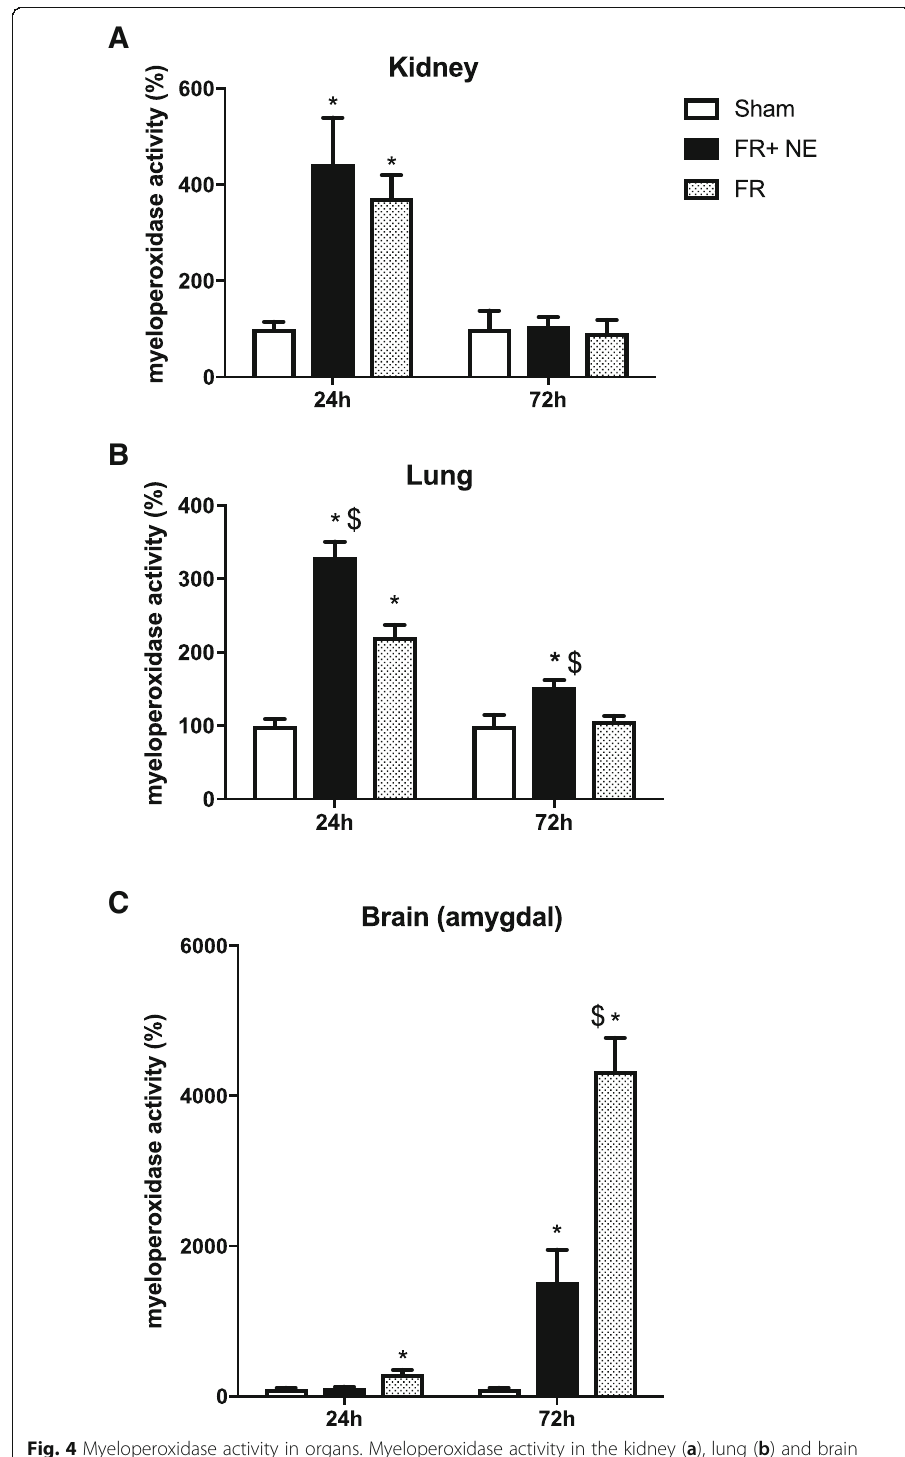
Fig. 4 Myeloperoxidase activity in organs. Myeloperoxidase activity in the kidney ( a ), lung ( b ) and brain amygdala ( c ), expressed as percentage of the mean of the sham group set as 100%, assessed by enzymatic reactions after 24 h and 72 h of reperfusion. N =5/group and asterisk indicates significant difference between HS vs sham group and dollar sign indicates FR vs FR+NE ( p